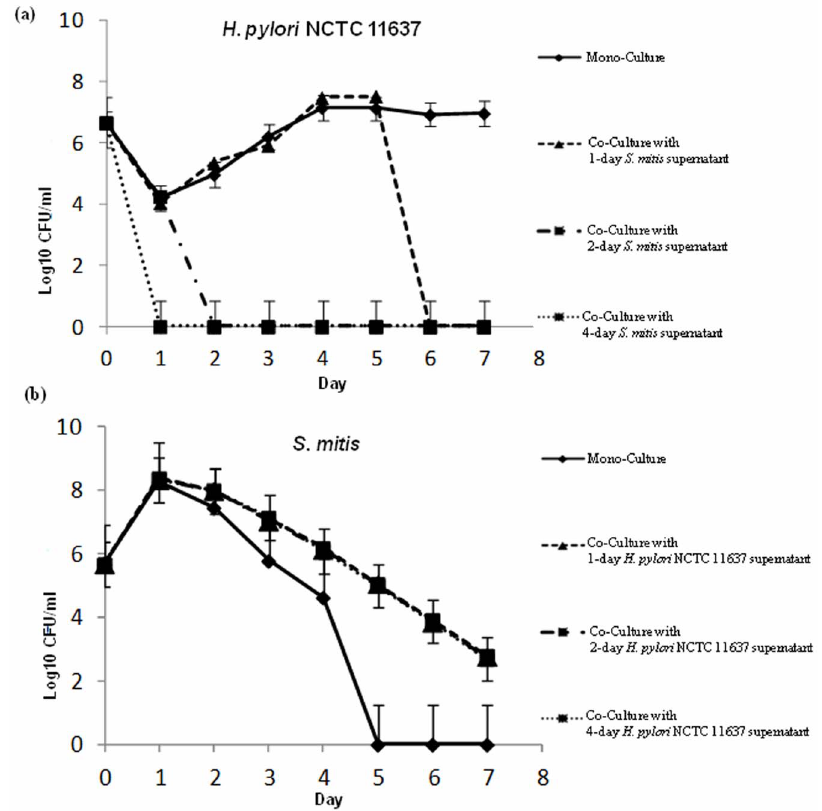
Figure 6. Effect of supernatant from the other bacterium on H.pylori and S.mitis . Mono-cultures of H. pylori (a) and of S. mitis (b) were supplemented with 1-, 2- or 4-day old supernatants from the other bacterium or left untreated. The colony forming units were determined by plating at the indicated time points.